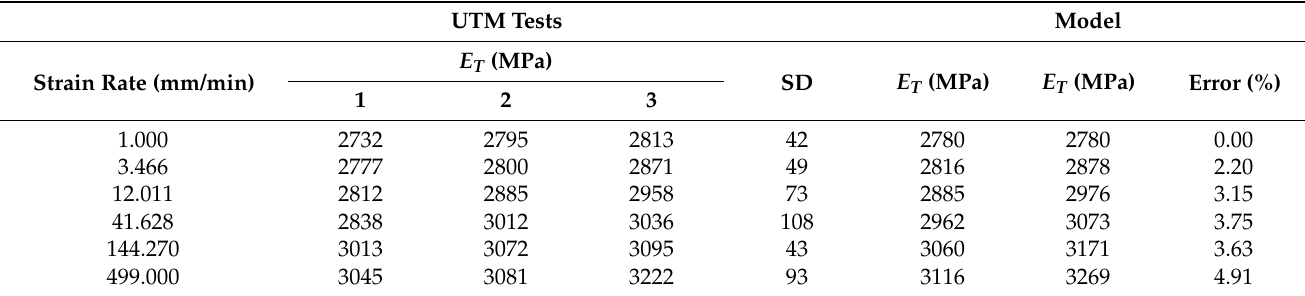
Table 4. Tensile modulus by tensile test in UTM compared to “synthetic” tensile modulus of PA66 for different strain rates at 23 ◦